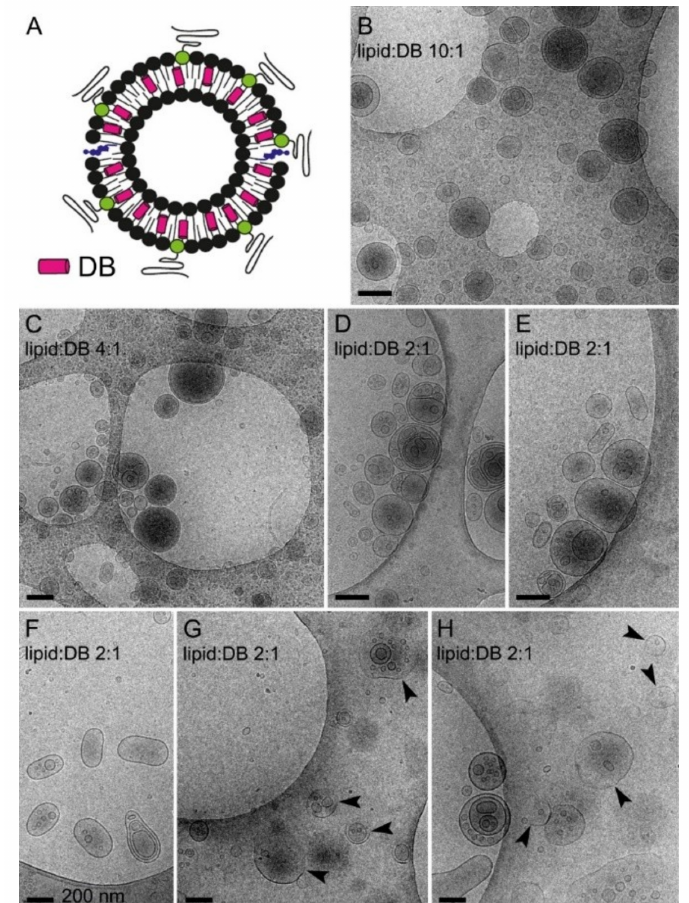
Figure 6. CryoTEM analysis. ( A ) Scheme of the DB-encapsulating liposome. ( B – H ) Images of liposomes containing di ff erent lipid:DB molar ratios. Arrowheads indicate deteriorated liposomes. Scale bars: 200